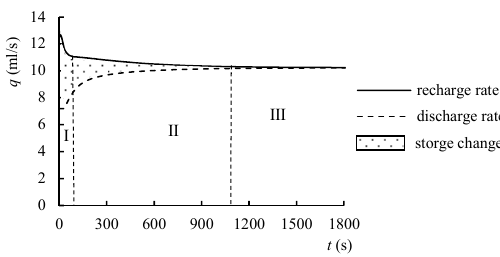
Figure 12. Calculation method of groundwater storage variation.